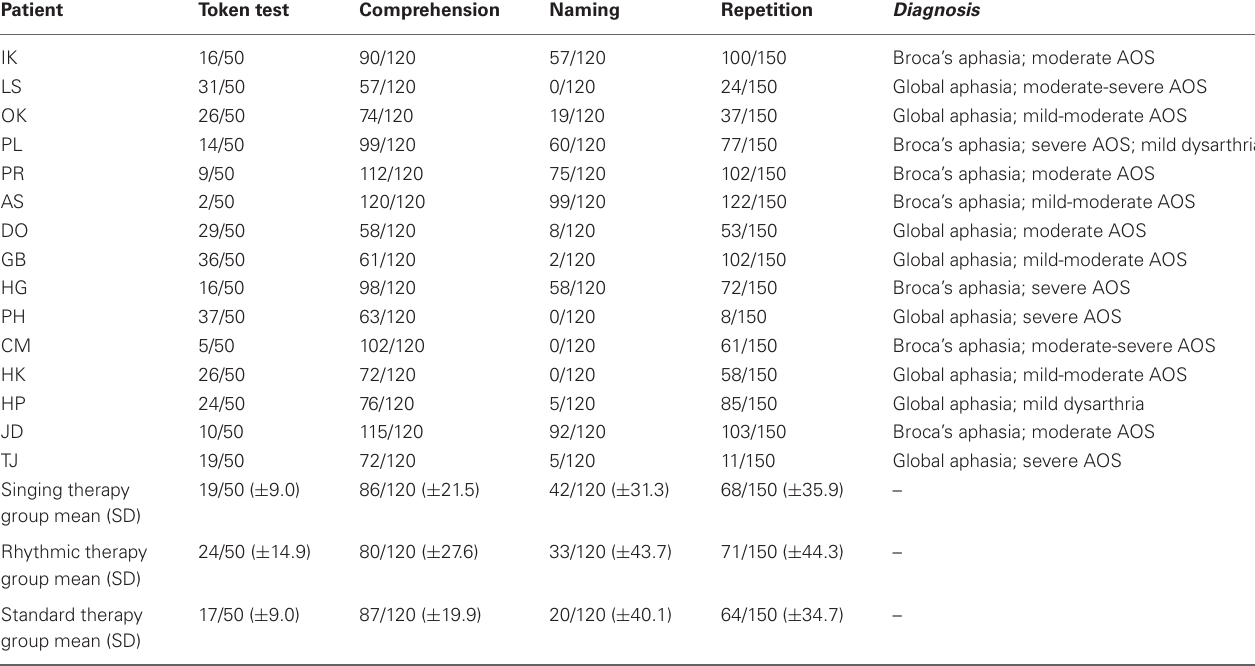
Table 2 | Language assessment.